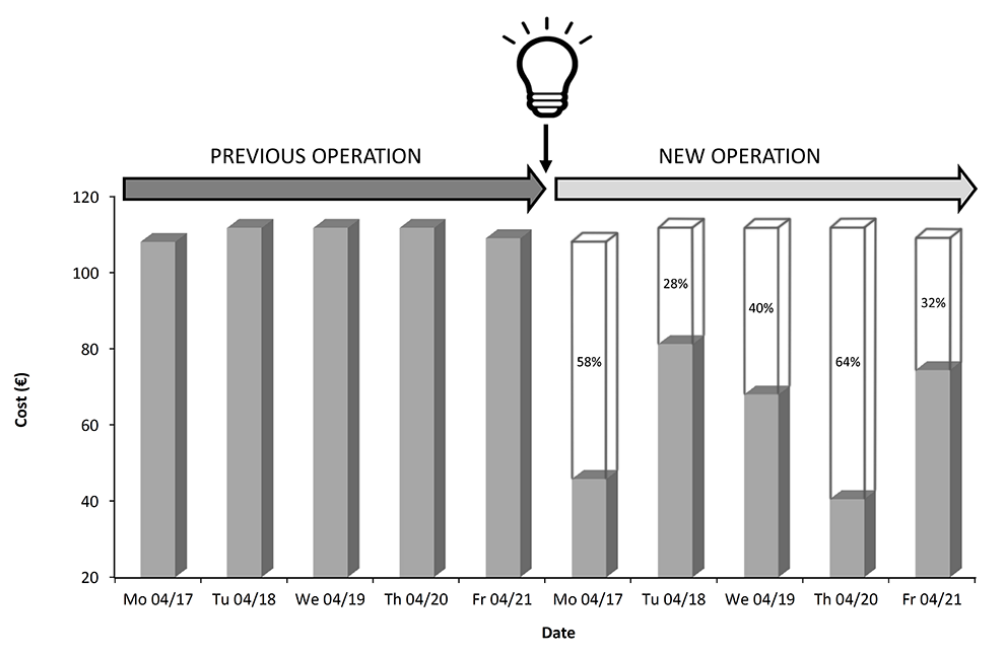
Figure 10. AHU energy costs for ventilation in building 4P with and without the EEM.